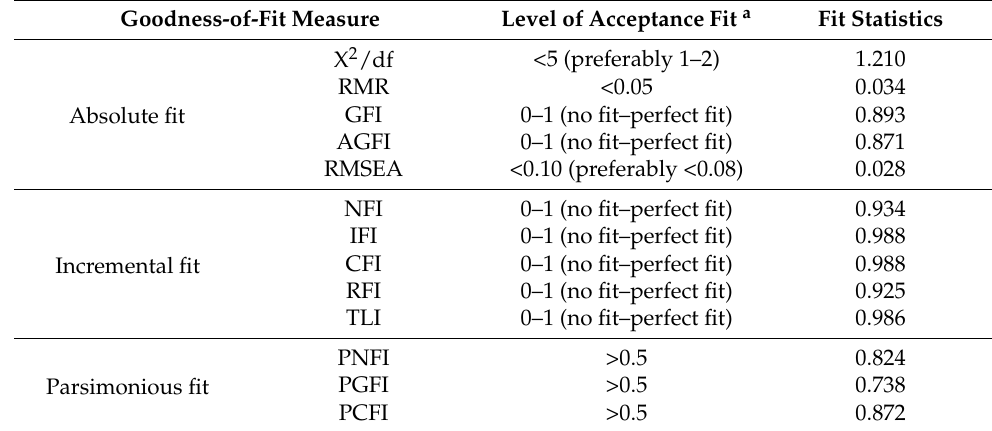
Table 4. Goodness-of-fit of the initial measurement model.